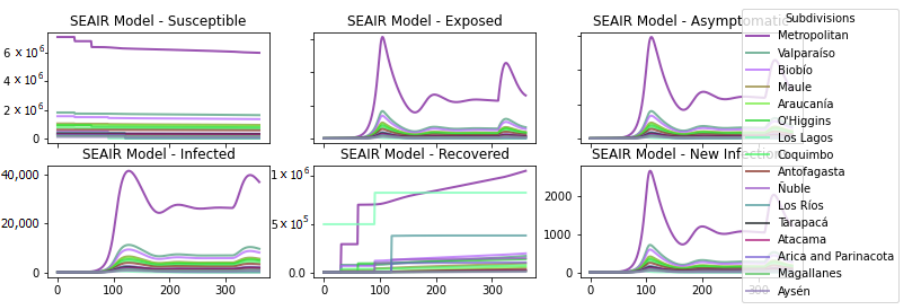
Figure 23. Susceptible, exposed, asymptomatic, infected, recovered, and newly infected individuals per day for each region of the SEAIR model with the best vaccination plan found.